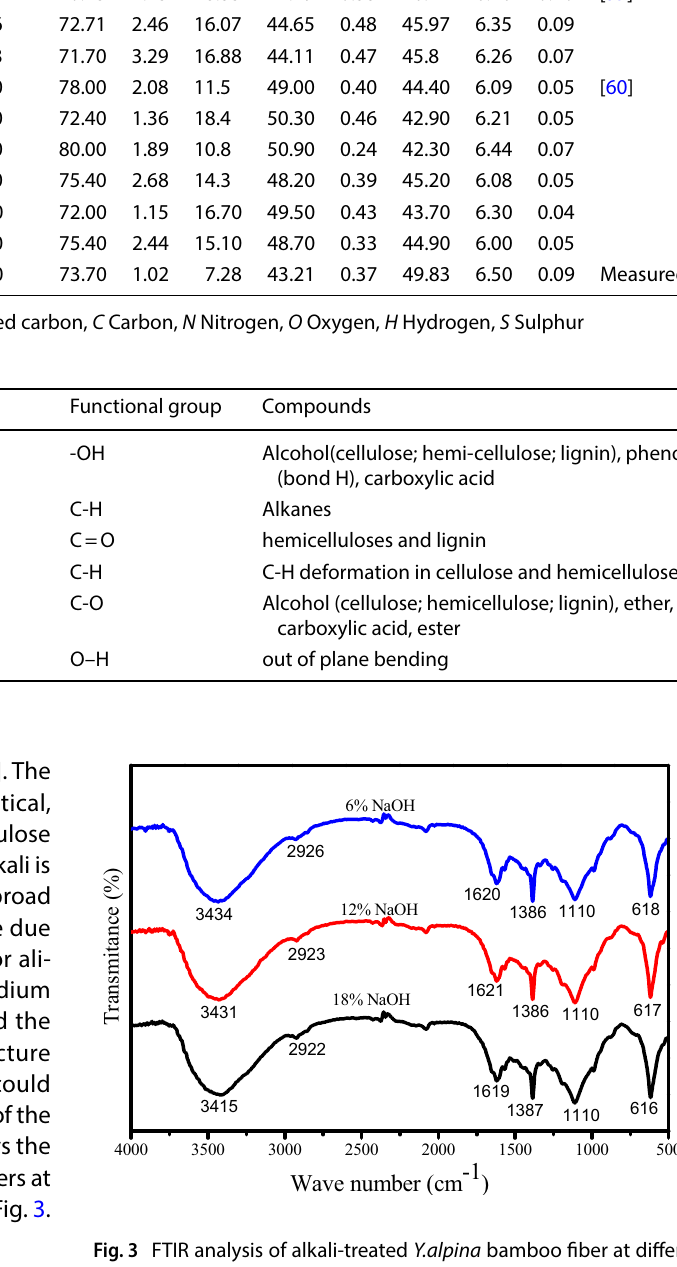
Table 6 Proximate and ultimate analysis of Y.alpina compared with other different bamboo species